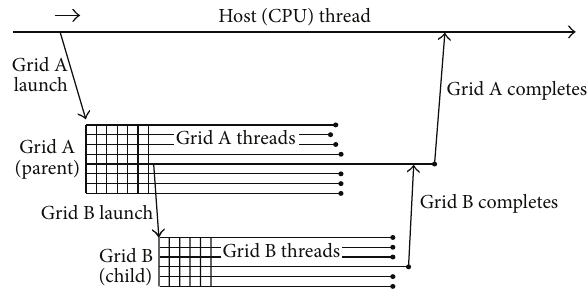
Figure 1: Parent-child launch nesting (derived from Figure 12 in